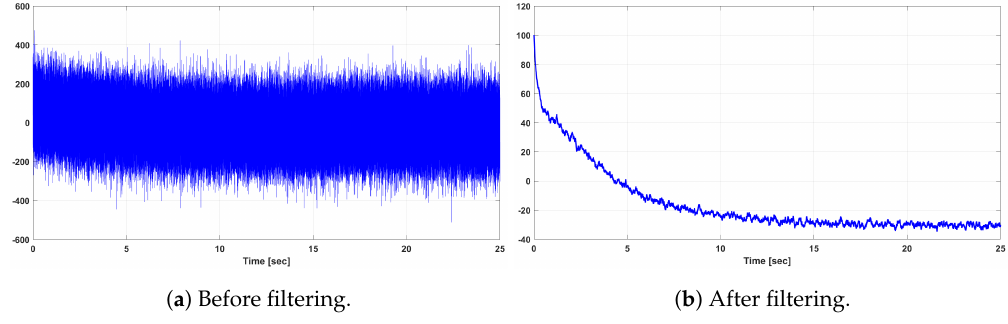
Figure 6. Original and reduced-order rotor current output i qr of the LQG-controlled DFIG WT system.